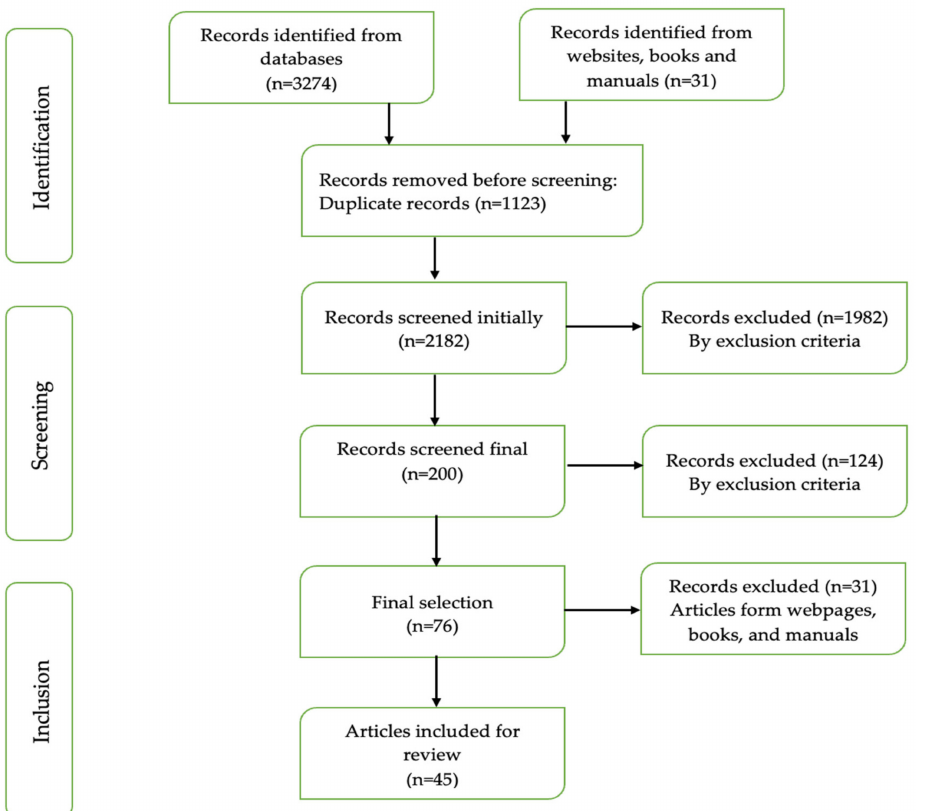
Figure 1. Flowchart for review process based on PRISMA guidelines.